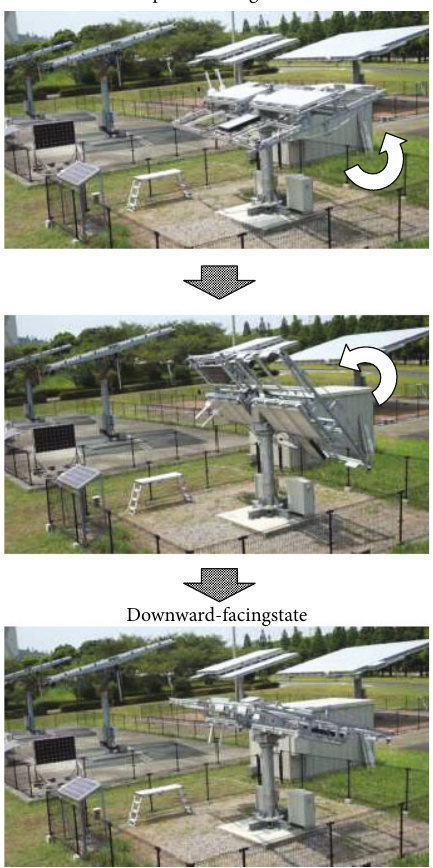
Figure 1: Photographs of the tracker system that can switch to a downward-facing standby state. During sandstorms and the night, this is performed by rotating all the PV